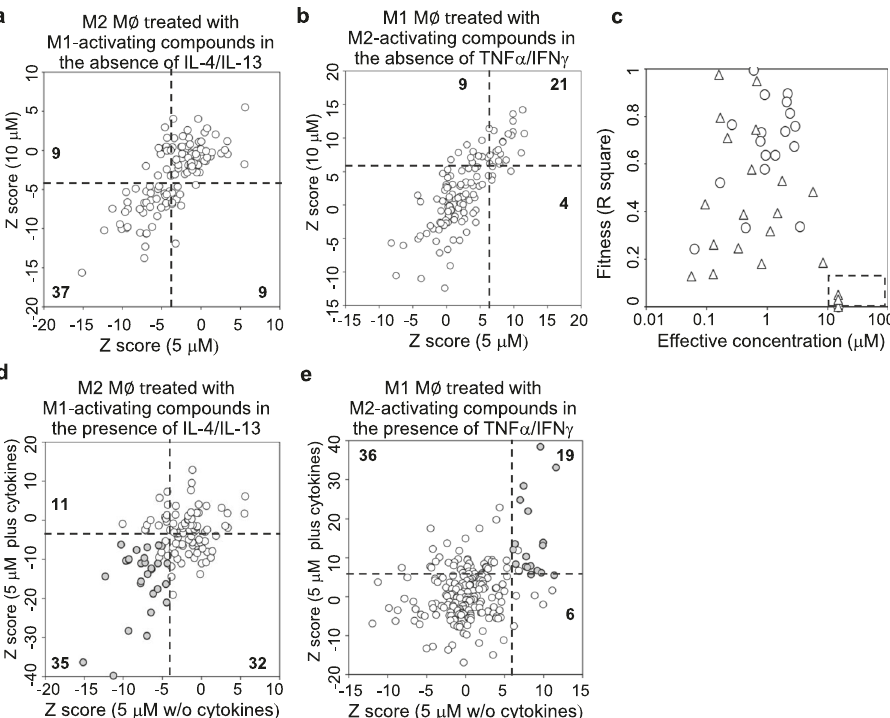
Fig. 3 Reprogramming screen of compounds on differentiated macrophages. a hMDMs were differentiated into M2 by IL-4 plus IL-13 and then treated with each of the 127 identi fi ed M1-activating compounds at either 5 or 10 μ M for 24 h in the absence of differentiating cytokines. Shown are comparisons of Z -scores between 5 and 10 μ M of compounds. b hMDMs were differentiated into M1 by IFN γ plus TNF α and then treated with each of the 180 identi fi ed M2-activating compounds at either 5 or 10 μ M for 24 h in the absence of differentiating cytokines. Shown are comparison of Z -scores between 5 and 10 μ M of compounds. c The effective concentration of 40 selected M1- or M2-activating compounds calculated from the dosage assays. EC and fi tness of 21 M1-activating (triangle) and 19 M2-activating compounds (circle) were calculated by the Michaelis – Menten equation and plotted. Data were summarized from three independent experiments. d – e hMDMs were differentiated into either M2 by IL-4 plus IL-13 or M1 by IFN γ plus TNF α and then treated with 127 M1-activating ( d ) or 180 M2-activating ( e ) compounds for 24 h in the presence of differentiating cytokines. Filled dots show identi fi cation of the same 37 M1-activating ( a ) and 21 M2-activating ( b )